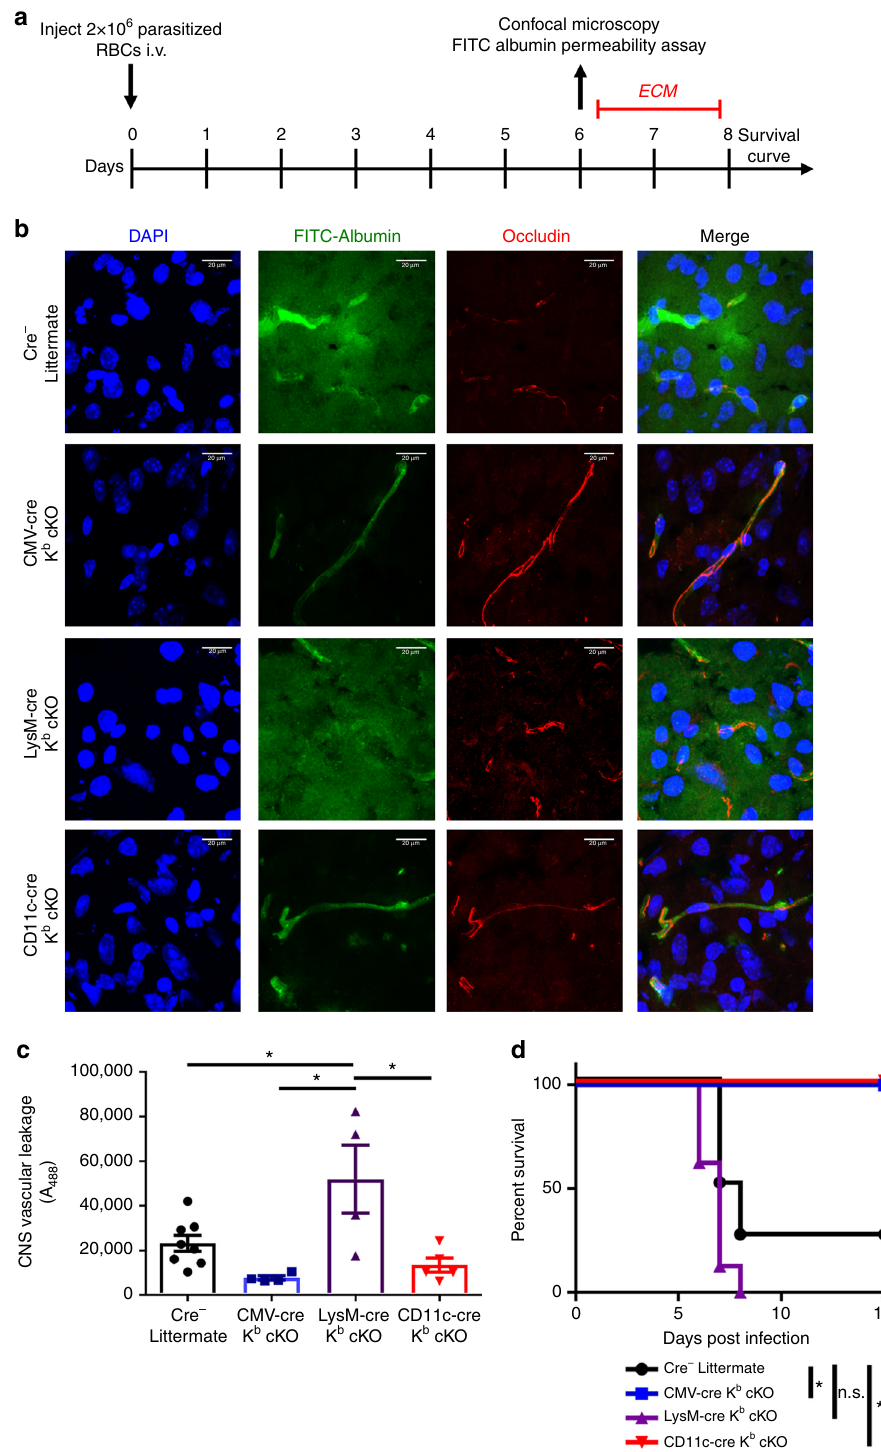
Fig. 5 Dendritic cell-speci fi c deletion of K b protects mice from lethal blood − brain barrier disruption. a Timeline of infection with Plasmodium berghei ANKA. b Representative microscopy images demonstrate blood − brain barrier disruption in cre-negative littermates and LysM-cre K b cKO animals, but not CD11c- cre or CMV-cre K b cKO animals. Scale bar represents 20 µ m. c Fluorescence of whole brain homogenate demonstrates extensive leakage of FITC-albumin in cre-negative littermates and LysM-cre K b cKO animals ( N = 8, 4, 4, 12 per group, respectively). d Dendritic cell-speci fi c, but not macrophage-speci fi c deletion of K b provided a survival advantage ( N = 8, 5, 8, 12 per group, respectively). Data presented as mean ± SEM. * denotes p < 0.05 by Mann − Whitney U Test or one-way ANOVA with Holm − Sidak